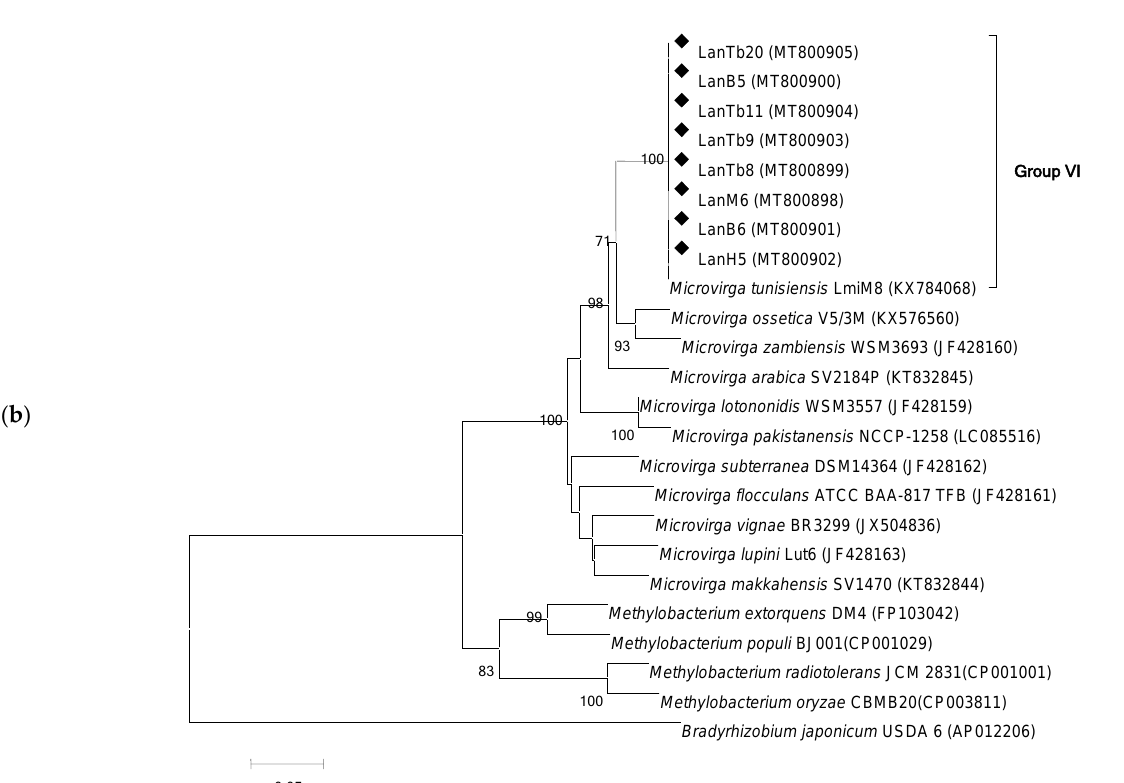
Figure 1. Neighbor-joining phylogenetic trees based on housekeeping recA ( a ) and gyrB ( b ) gene sequences of Tunisian L. angustifolius -nodulating isolates in this study and reference strains. Black diamonds ( ◆ ) indicate Tunisian strains. Bootstrap values (above 70%) using 1000 replicates are indicated at branching points. Accession numbers are shown in brackets. Bars: 0.1 and 0.05 estimated substitutions, respectively.